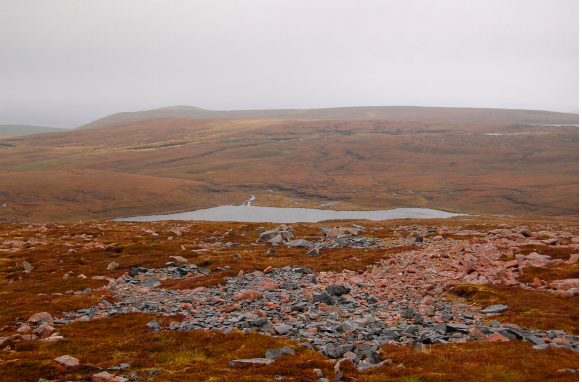
Figure 2. A Felsite Workshop at the Beorgs of Uyea. Felsite is visible in blue against Red Ronas Granite (Images by the Authors).